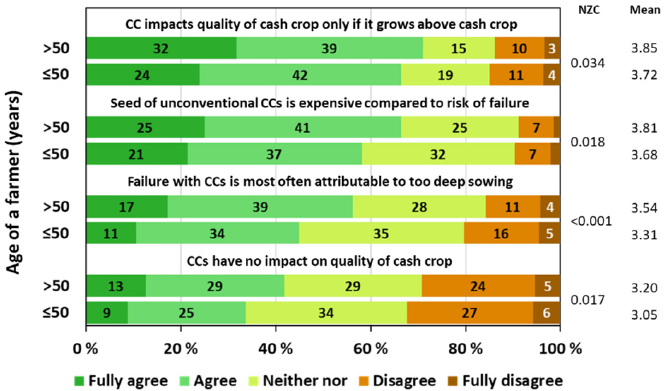
Figure 2. The distribution of farmers’ answers (N = 1130) depending on the farmer’s age (NZC, nonzero correlation; CCs, cover crops). The share of each answer choice (%) is shown within each bar. Means with the same letter do not differ significantly from each other (at p ≤ 0.05).